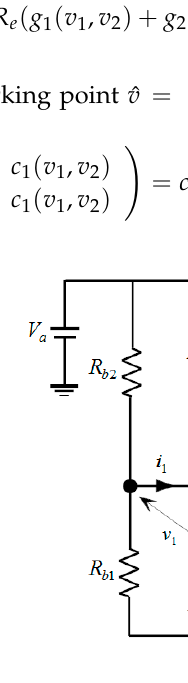
Figure 4. The considered electronic circuit.